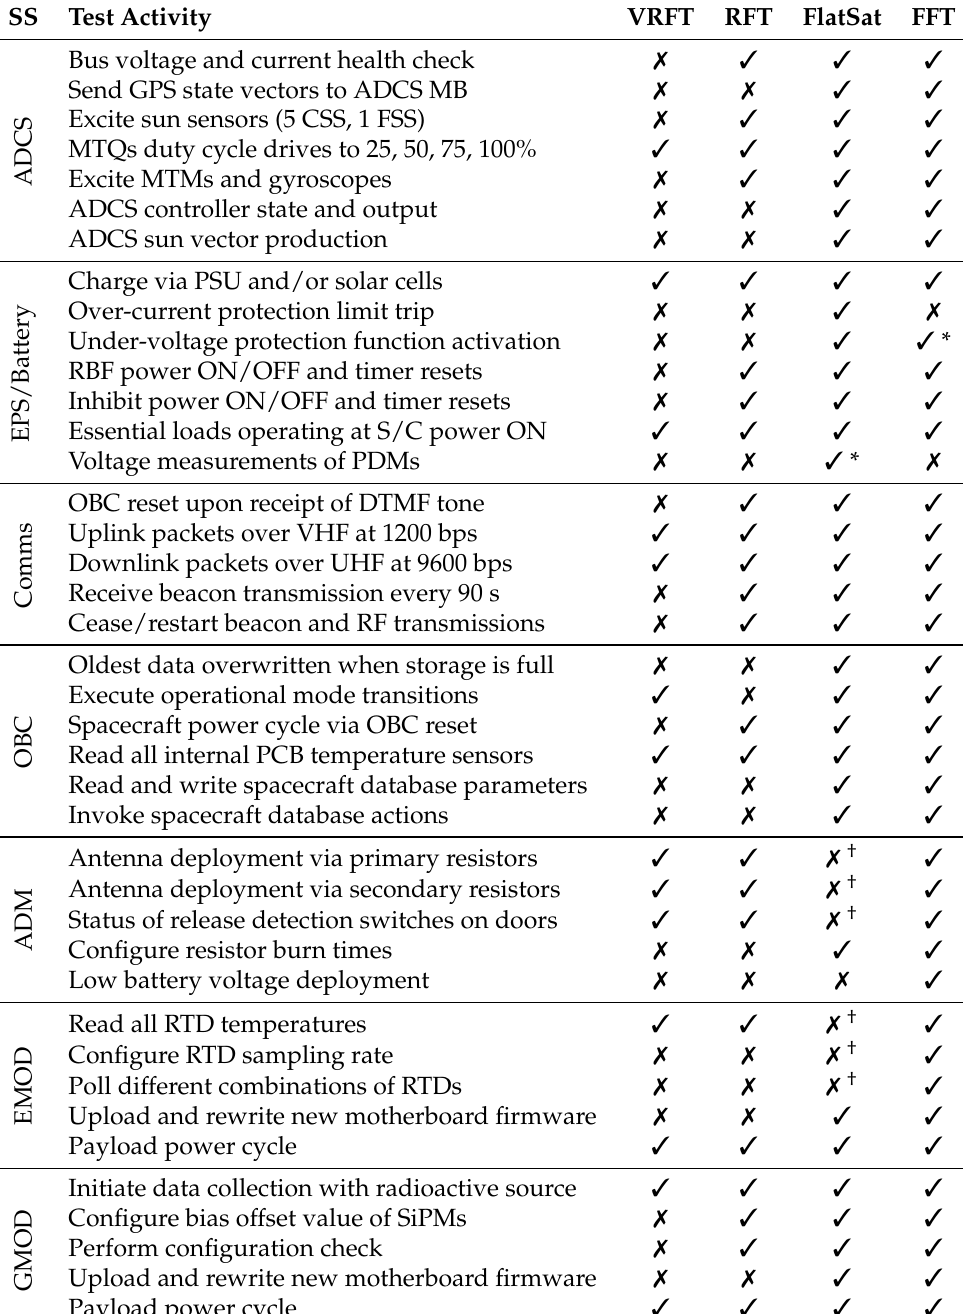
Table 1. The functional test activities of the EIRSAT-1 EQM for the very reduced functional test (VRFT), reduced functional test (RFT), FlatSat functional test, and full functional test (FFT). All tests listed are performed during the FFT. Subsets of these tests are performed during the RFT and VRFT. Some tests were not performed on the EQM FlatSat but will be implemented into the FM FlatSat campaign. Wave-Based Control (WBC) tests are not included as they are only performed at FM level.